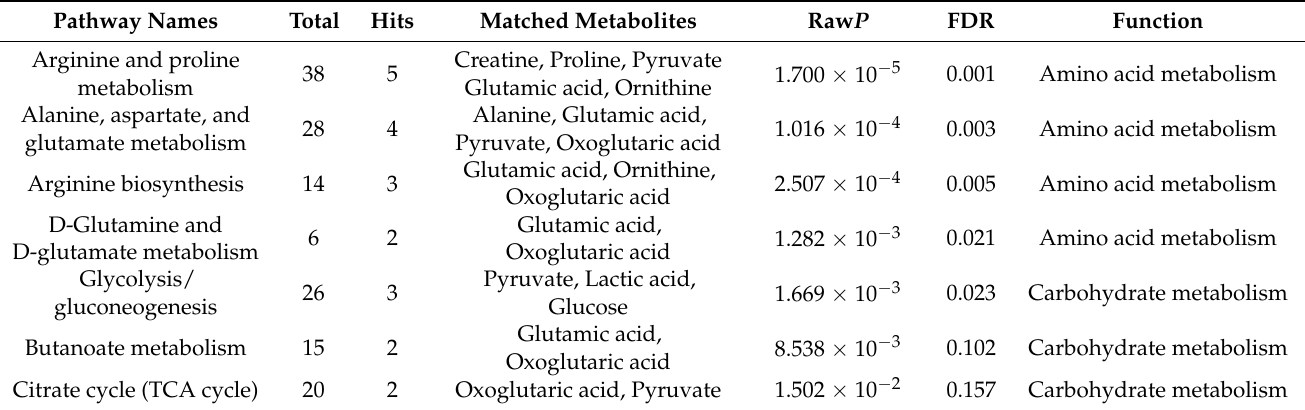
Figure 1. Heatmap of Spearman’s rank correlations of metabolites significantly differentially expressed within different statuses of cholesterol level with lipid profile levels ( A ). Color intensity represents the magnitude of correlation. + symbol means a p -value < 0.05; ++ symbol means a p -value < 0.01. Markers for differentiating children with different cholesterol statuses identified from random forest classifiers based on the significantly differentially expressed metabolites with metabolite profile only ( B ) or a combination with baseline characteristics ( C ). Markers are ranked in descending order of their importance to the accuracy of the model. The boxes represent the 25th–75th percentiles, and black lines indicate the mean. Table 3. Metabolic and functional pathway of metabolites associated with different statuses of cholesterol